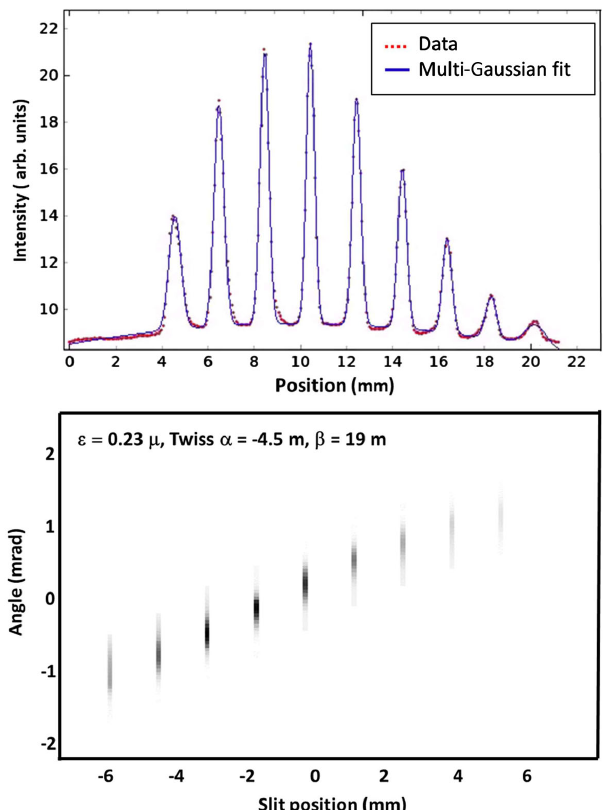
FIG. 8. Phase-space measurements in the injection line using a multislit mask for a bunch charge of 75 pC. Top: Vertical intensity profile at the YAG profile monitor when a multislit mask is inserted upstream. Bottom: Result of the transverse phase-space reconstruction at the multislit mask location with the listed geometric emittance ε and the Twiss parameters α and β